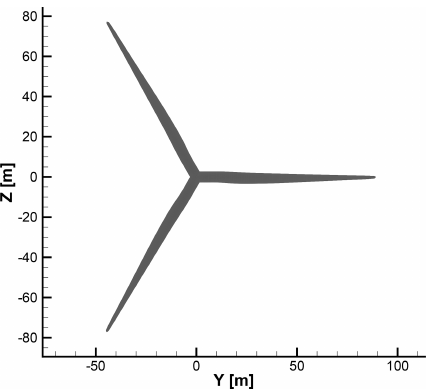
Figure 4. Baseline geometry used in the flow solver comparison and as starting point for the optimization. Each blade has a surface mesh with 36 square blocks. Each block has 32 × 32 cells, resulting in 110592 surface mesh